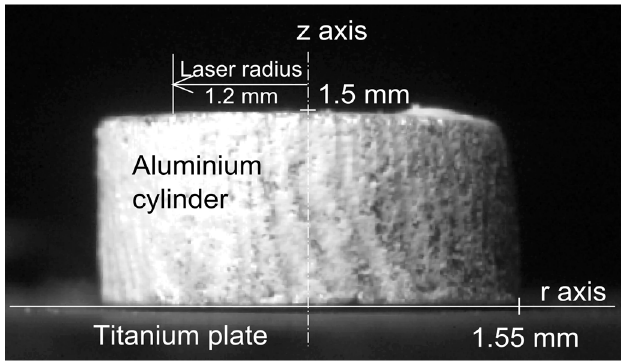
Figure 3. Axisymmetric experimental set-up of laser-assisted aluminum wetting on